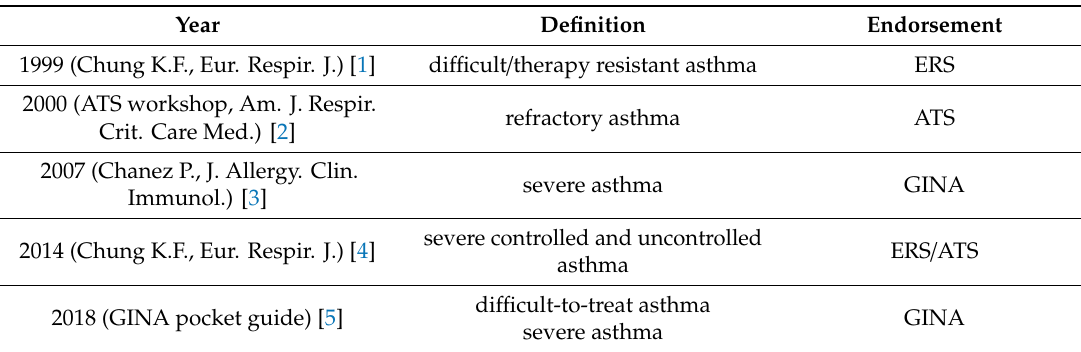
Table 2. Evolution of the definition of severe